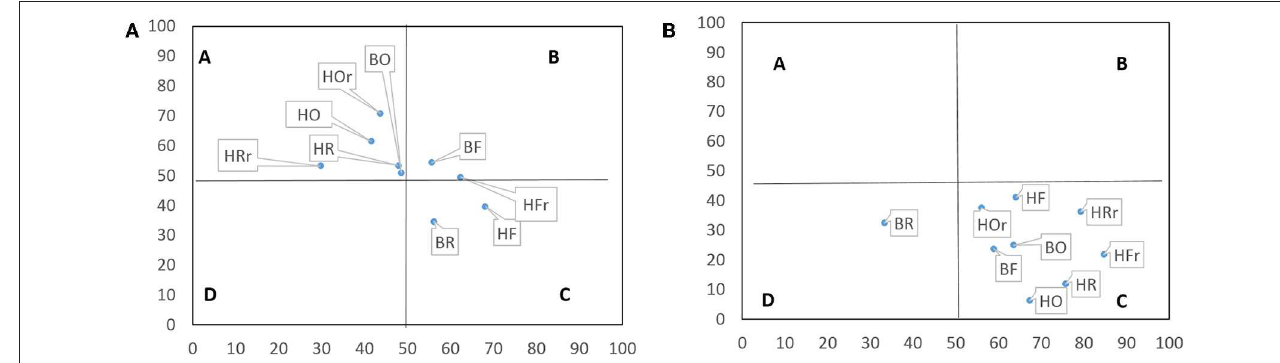
FIGURE 3 | Nematode faunal profile in litter (A) and soil (B) . The vertical axis represents enrichment and the horizontal axis structure. Quadrats refer to the faunal profile A, B, C, and D (Ferris and Bongers, 2009); F, rainforest; R, rubber; O, oil palm plantation; r, riparian; H, Harapan; B, Bukit Duabelas, n = 4.